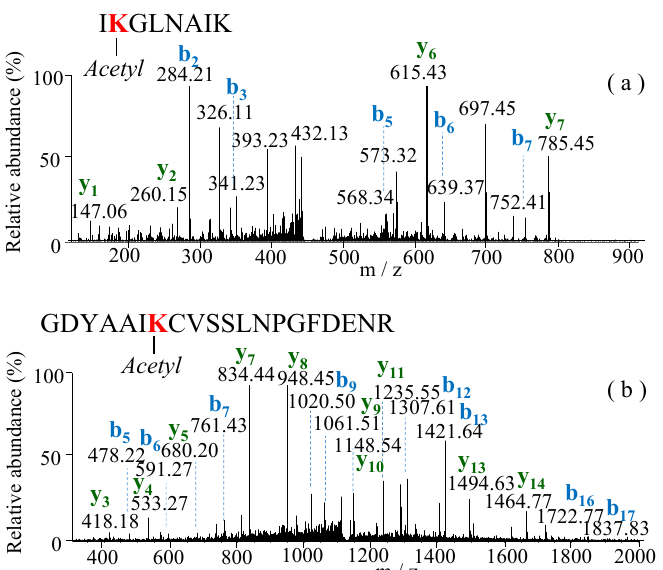
Figure 8. Identification of acetylated-lysine-containing peptides of 4HA13. ( a ) MS/MS spectrum of peptide 262–269 at m/z 449.7904 of a major capsid protein; ( b ) MS/MS spectrum of peptide 37–56 at m/z 1128.0223 of a tail completion protein. Symbols of b and y ions denote the fragments extended from the N-terminus and C-terminus of the peptides, respectively.